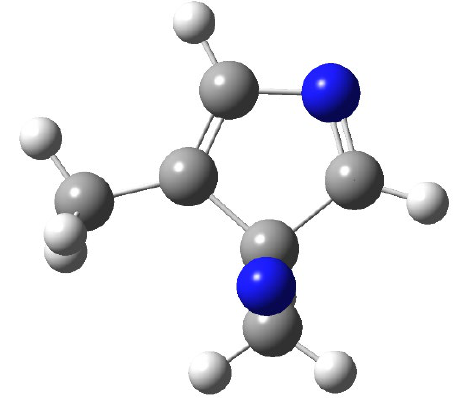
Figure 5. CASSCF evolution of the singlet excited state of 2,6-dimethylpyrazine.